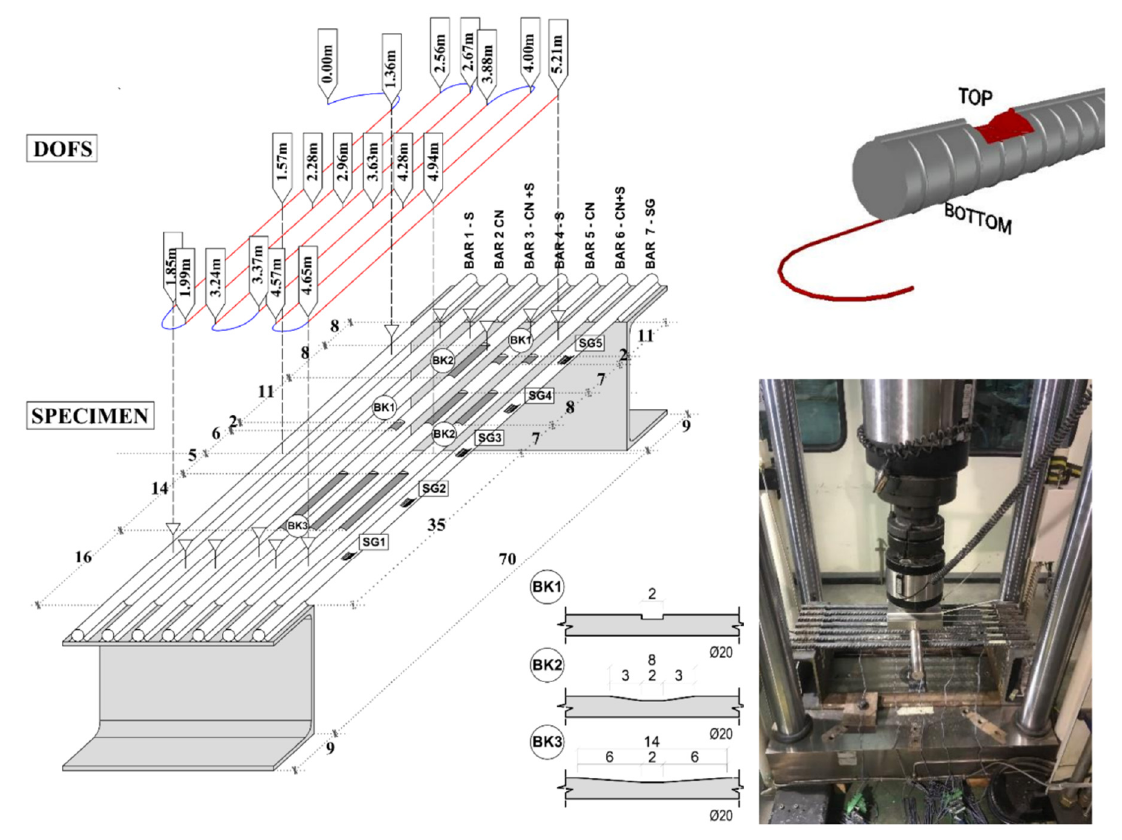
Figure 6. Test setup: three-dimensional specimen detailing and photography